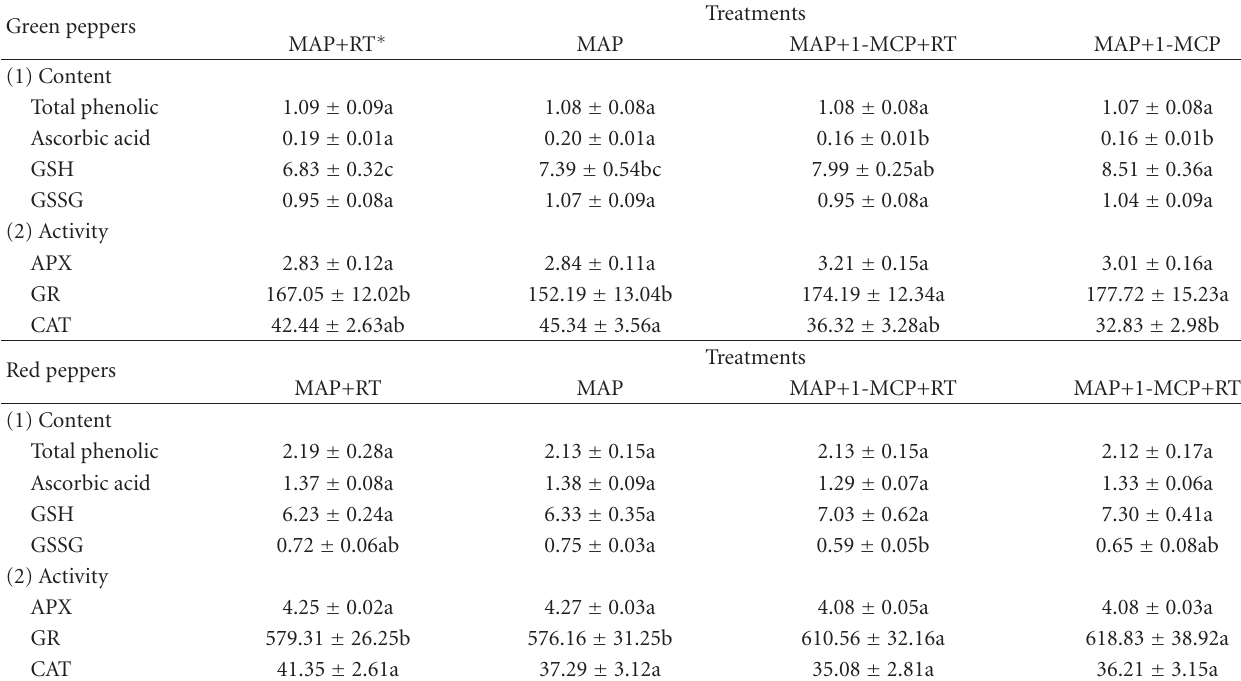
Table 1: E ff ect of MAP and MAP+1-MCP treatment on antioxidant constituents in mature green peppers and fully ripe/red peppers during low-temperature storage.